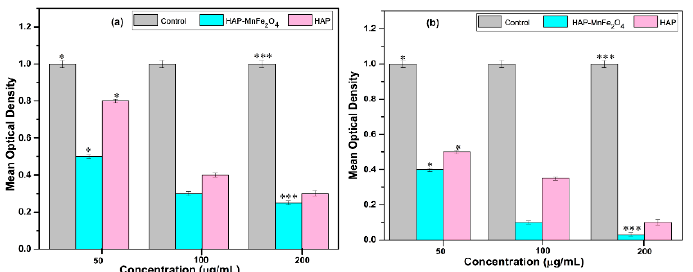
Figure 9. Bar graphics of ( a ) E. coli culture augmented with different quantities of HAP and HAP-MnFe 2 O 4 nanocomposite (optimal expansion signifies E. coli and S. aureus in culture broth without HAP and HAP-MnFe 2 O 4 ). Substantial difference (* p ≤ 0.05) was perceived in bacterial growth inhibition among control group and treatments at all concentrations. Significant difference in bacteriostatic impact with HAP and HAP-MnFe 2 O 4 at higher amount was visualized. * p ≤ 0.05, *** p ≤ 0.001 significantly dissimilar from untreated control.